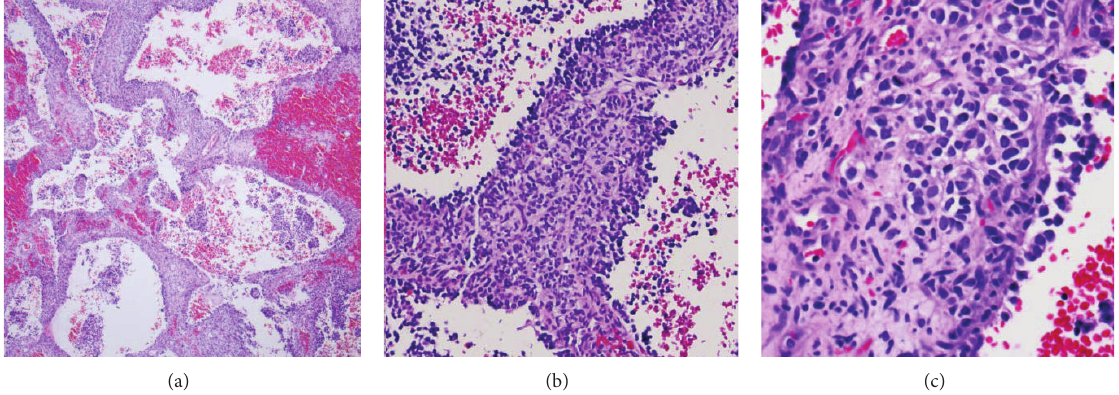
Figure 2: Histologic features of tumor in the left inguinal lymph node. (a) The RMS-like component showed variably sized cystic spaces separated by fibrovascular septa. (b) Cystic spaces lined by loosely cohesive primitive cells floating into spaces, imparting an alveolar pattern. (c) The tumor cells demonstrated nesting pattern within the fibrovascular septa (hematoxylin-eosin, original magnification × 40 (a); original magnification × 200 (b); original magnification × 400 (c)).